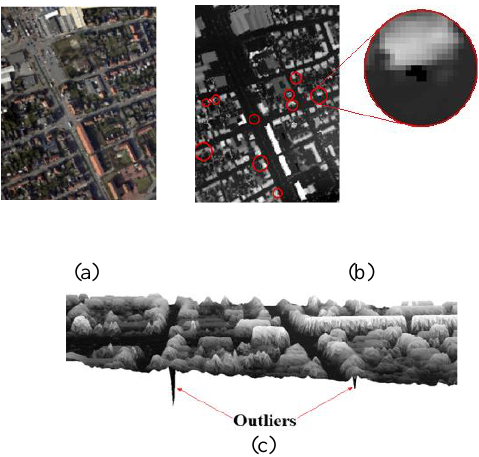
Figure 2. Study area: (a) Aerial image (b) Last return LiDAR data (c) 3-D view of DSM